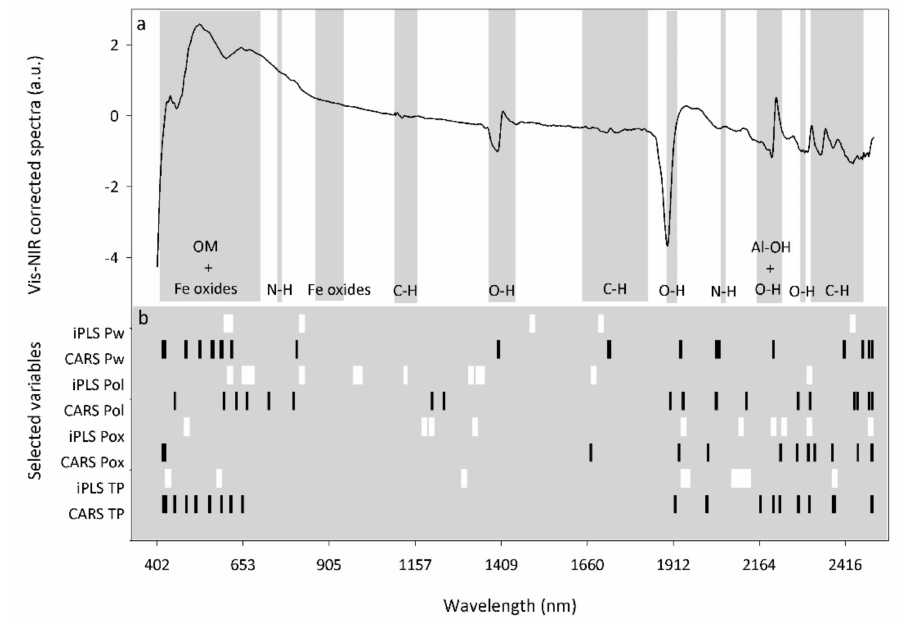
Figure 4. Representative vis-NIRS-corrected spectra with associated absorption bands for the di ff erent bonds present in soil ( a ) and selected variable regions ( b ) by iPLS (white) and CARS (black) for water-extractable P (Pw), Olsen P (Pol), Oxalate-extractable P (Pox) and total P